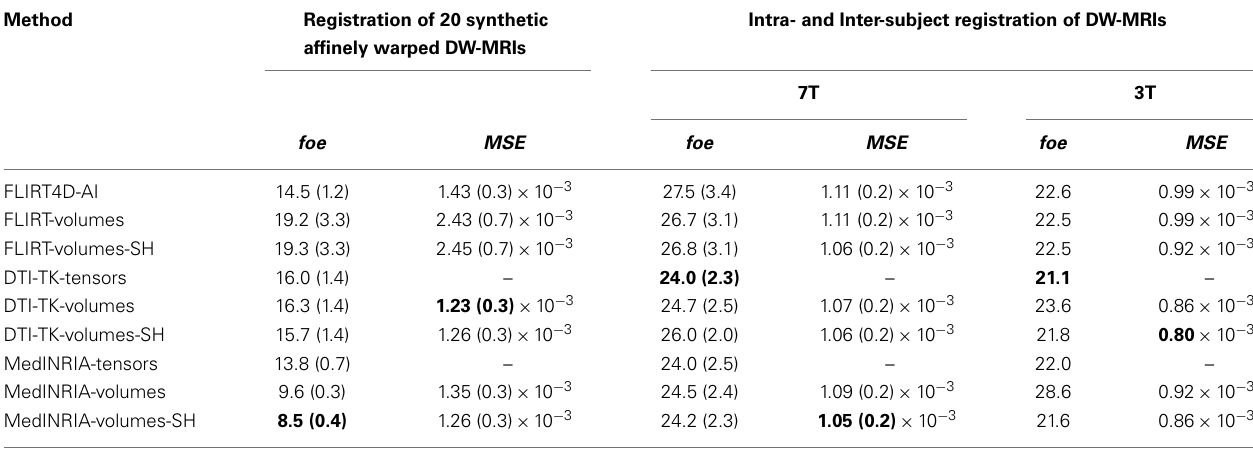
Table 2 | Linear registration (best results are indicated in